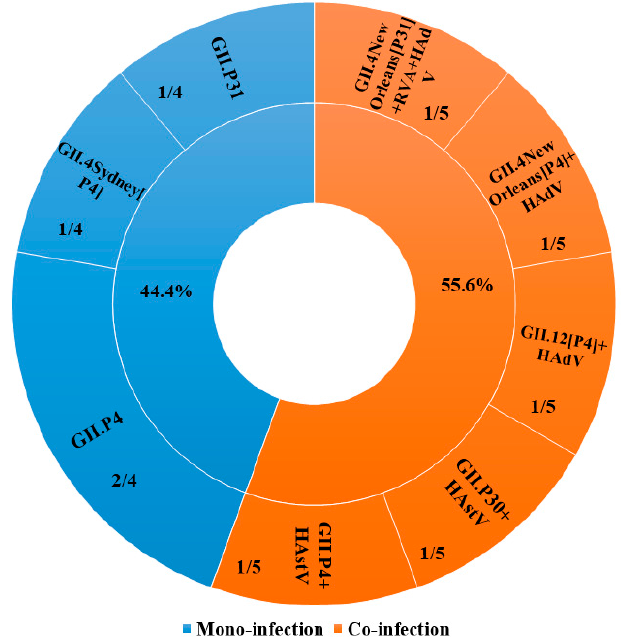
Figure 1. Co-infection patterns of NoV in children with acute gastroenteritis in Ogun State, Nigeria, from February 2015 to April 2017.